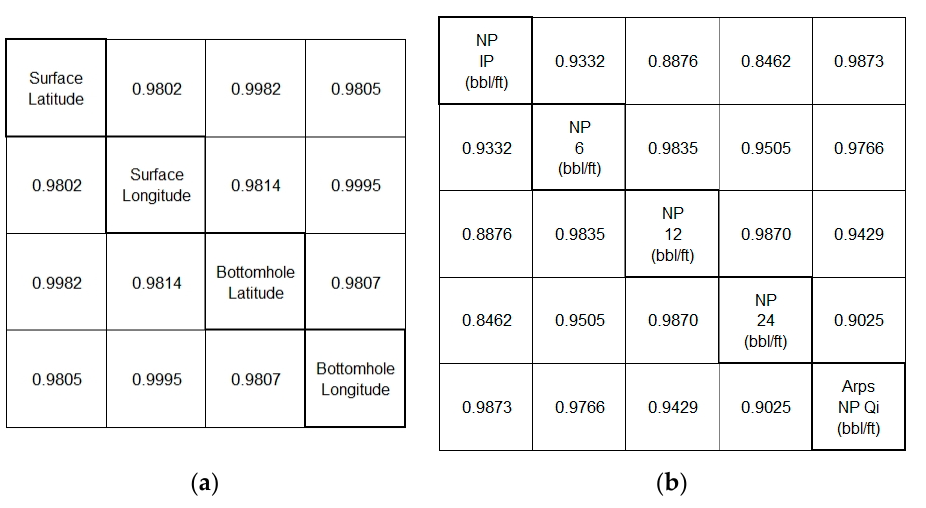
Figure 8. Correlation coefficients among input attributes. Well productivity depends on the native parameters of shale formations and the suc- cess of the hydraulic fracturing design. PCA was conducted to reduce and summarize the correlated multidimensional variables and identify the key factors among the limited da- tasets. Factors that have a major influence on the various attributes related to production were identified as key factors in this study. Four case studies and PCAs were performed for the input attributes to identify the key factors, as listed in Table 4. Table 4. List of input attributes in the case studies. Case 1